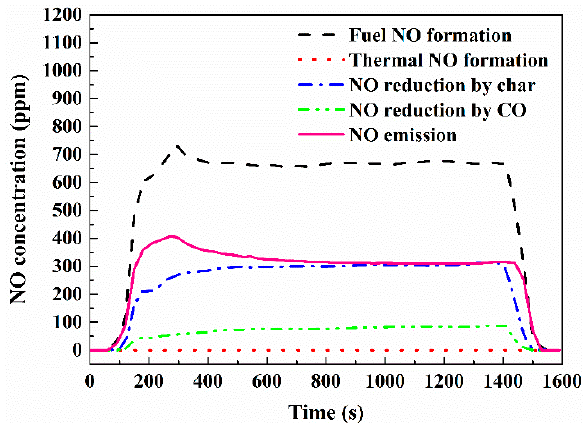
Figure 4. Quantification of NO formation and reduction for overall NO emission ( base case ).